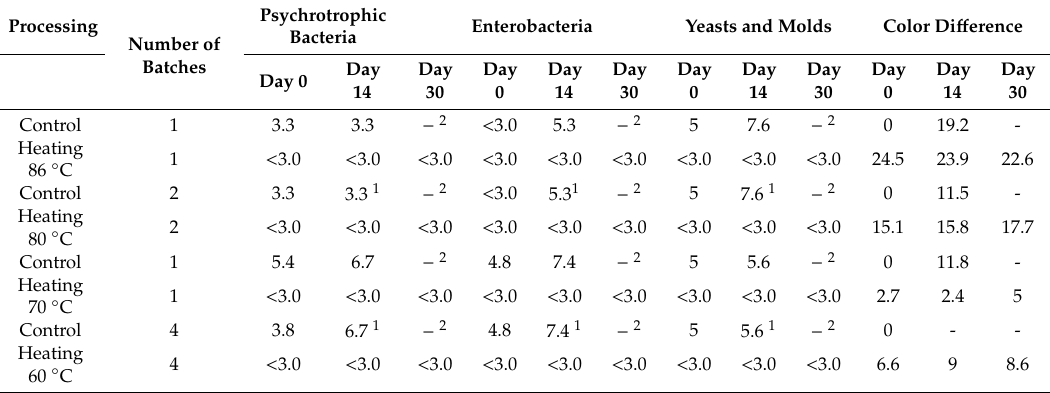
Table 6. Microbiological counts for unpasteurized and pasteurized pineapple juice at di ff erent temperatures and at di ff erent refrigerated storage